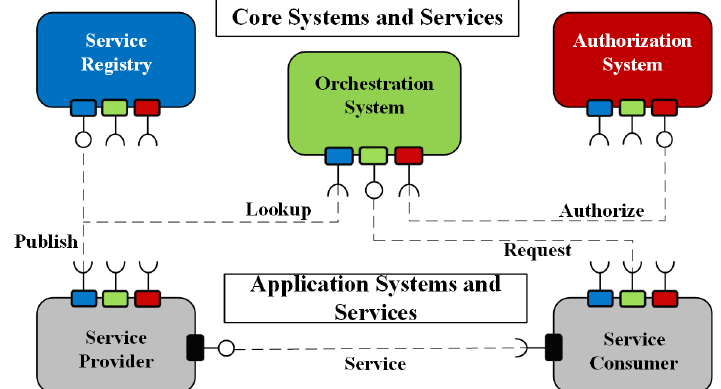
Figure 2. The core elements of the Arrowhead Framework are connected in a service-oriented way.